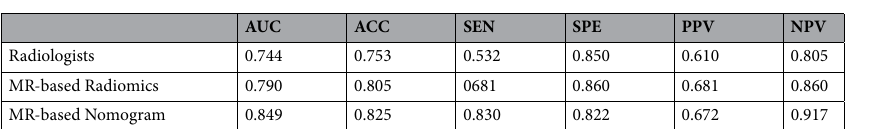
Table 4. The diagnostic performance comparison between radiologists and computers in prediction placenta accreta or increta in testing group (N = 154).